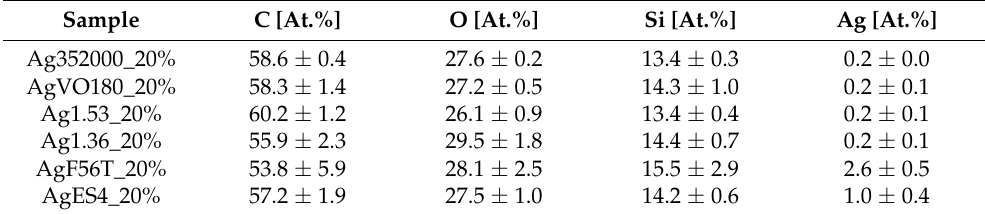
Table 2. EDX analysis of samples with silver containing coating (20% addition).